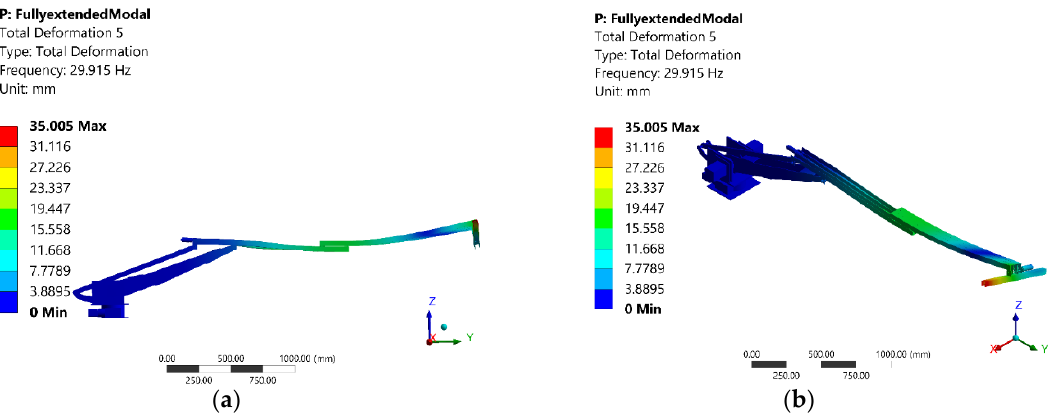
Figure 10. The 5th mode shape of vibration for the Fully-extended configuration, arm is fixed at the base ( a ) side view & ( b ) isometric view.